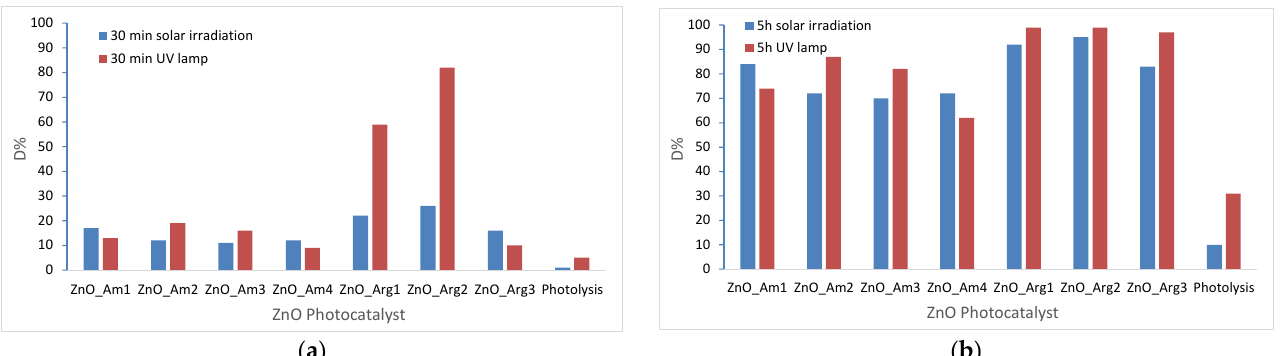
Figure 6. Degradation efficiencies of ZnO samples for MB photodegradation in the presence of artificial and solar light ( a ) after 30 min irradiation; ( b ) after 5 h irradiation.